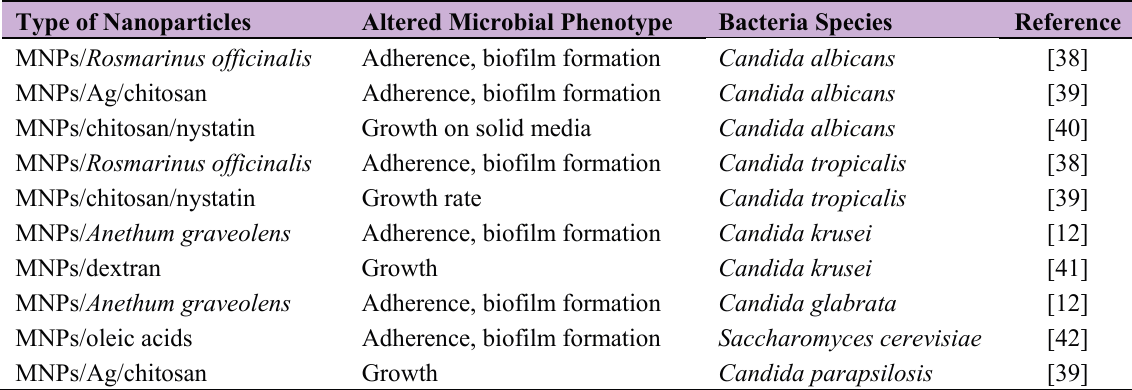
Table 3. List of MNPs in combination with active compounds to inhibit